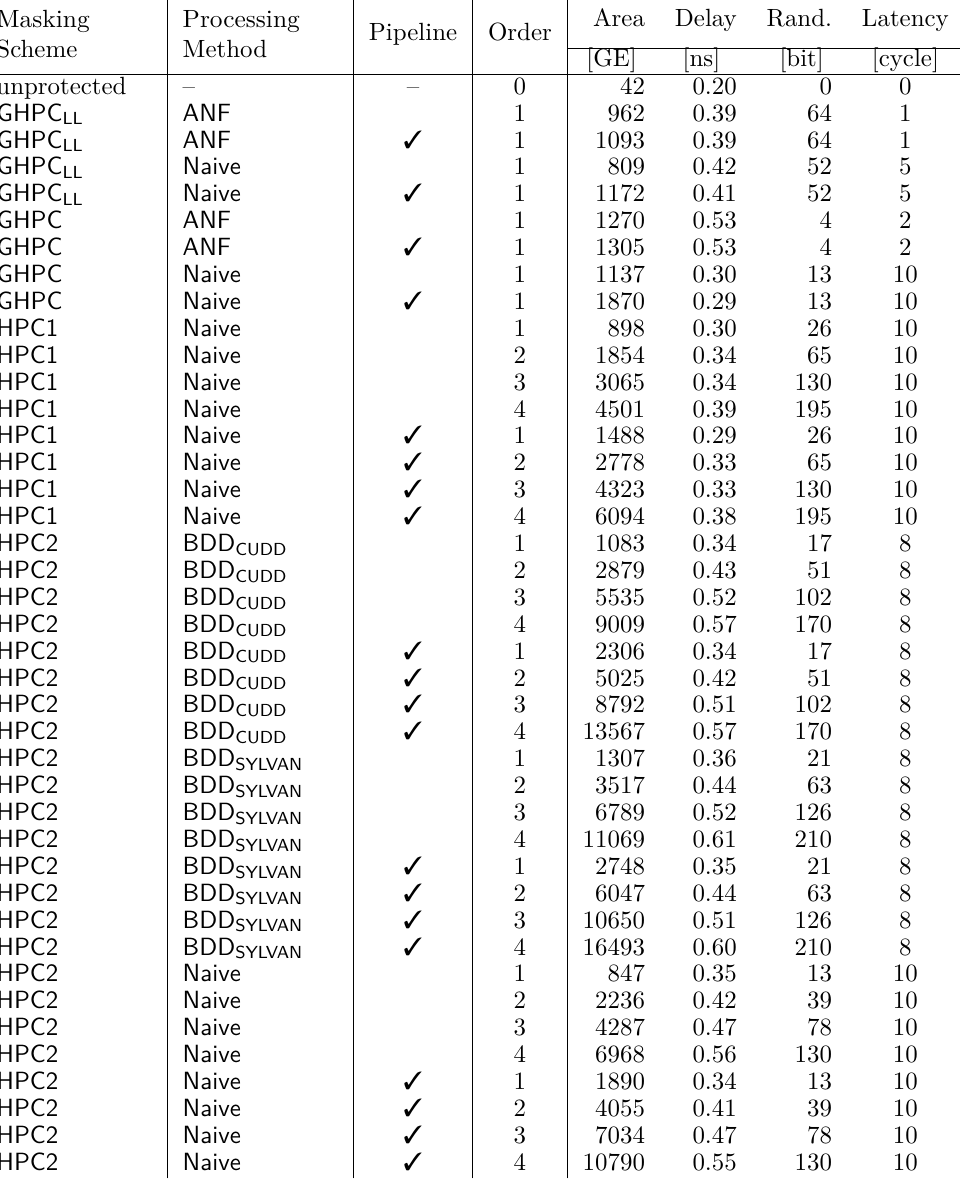
Table 3: Synthesis results, Skinny S-box lookup-table